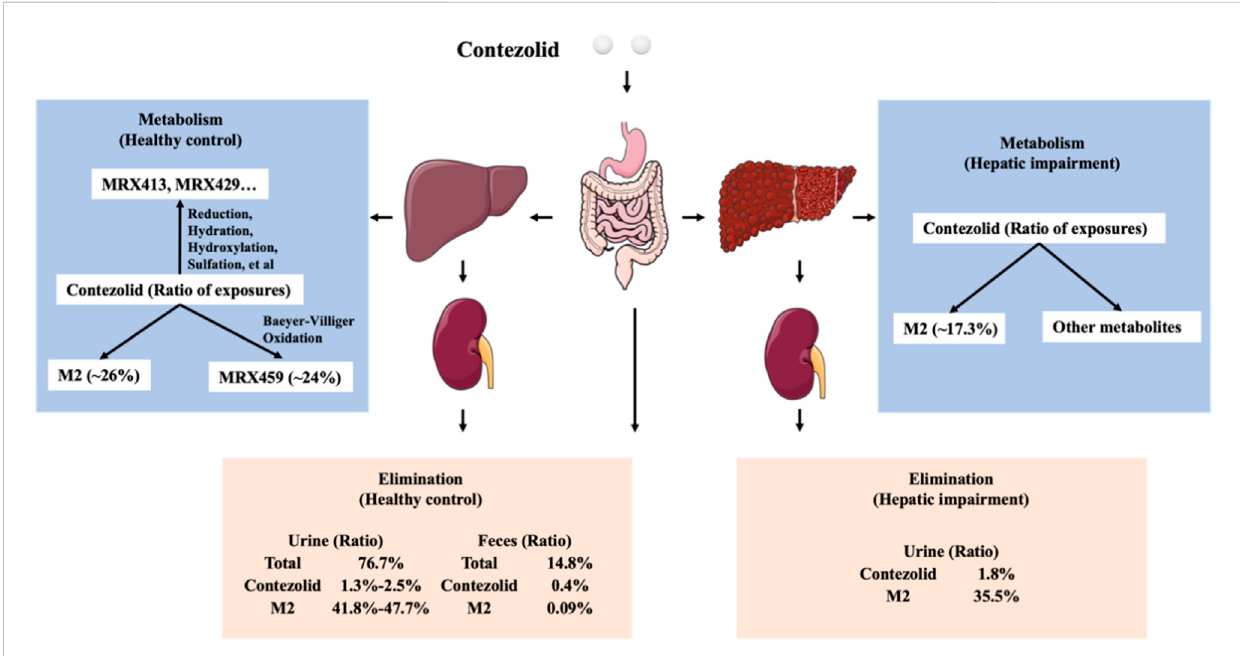
FIGURE 4 Comparison of metabolism and elimination of contezolid in terms of PK parameter ratios between the patients with moderate hepatic impairment and healthy controls with normal liver function.